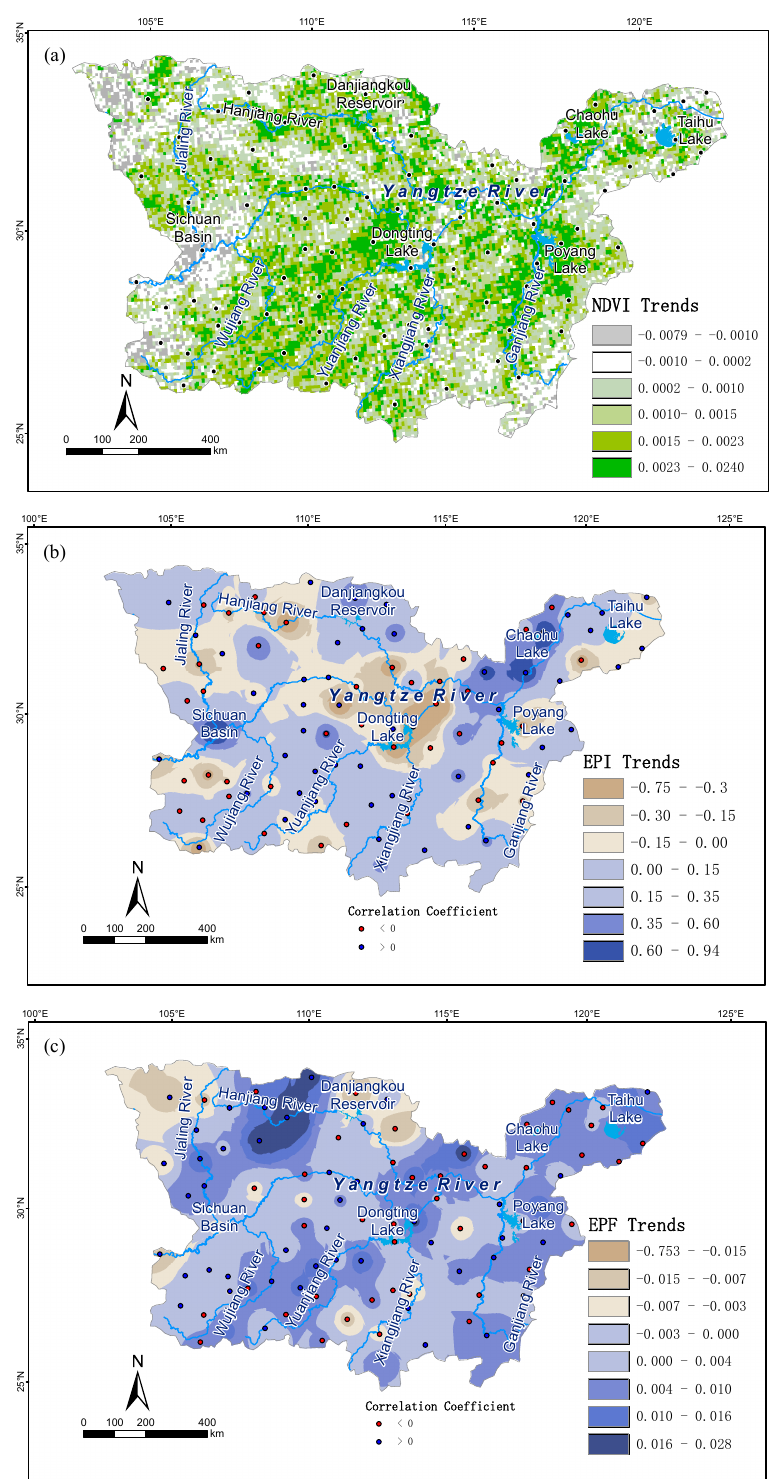
Figure 4. Spatial trends of ( a ) maximum NDVI, ( b ) EPI and ( c ) EPF in the MLR-YR from 1982 to 2012. Blue (red) points represents positive (negative) correlation between maximum NDVI and ( b ) EPI and ( c ) EPF.